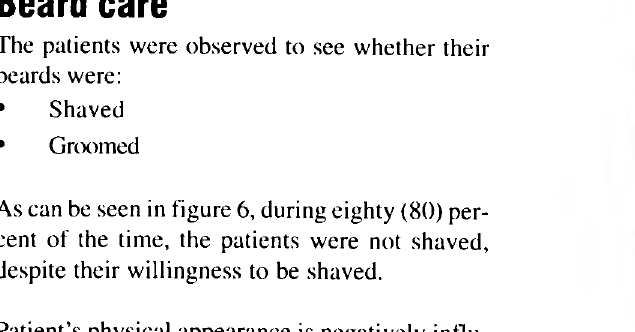
Figure 5 : Outcome of nose care as percentage of total observations (N = 30)